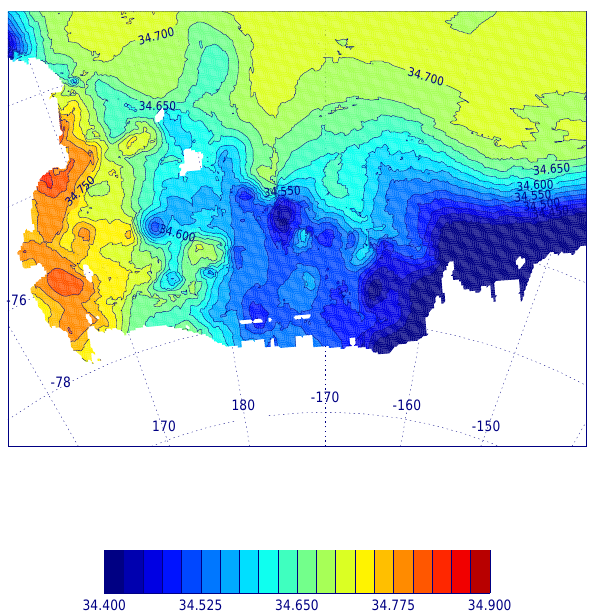
Fig. 4. Climatological salinity at 300m from Orsi and Wiederwohl (2009). White areas in the figure are either land, areas that are shal- lower than 300m or areas with no data (i.e. beneath Ross Ice Shelf).